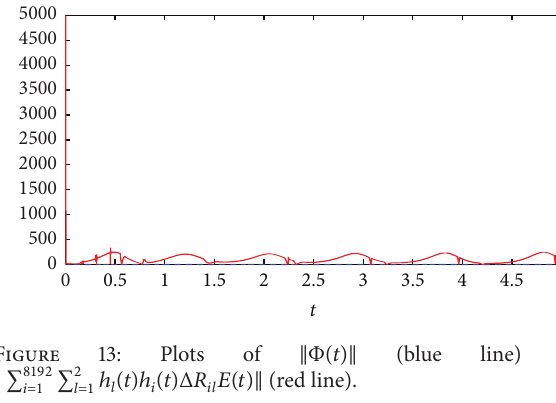
Figure 11: The chaotic behaviors of the master and the slave systems.